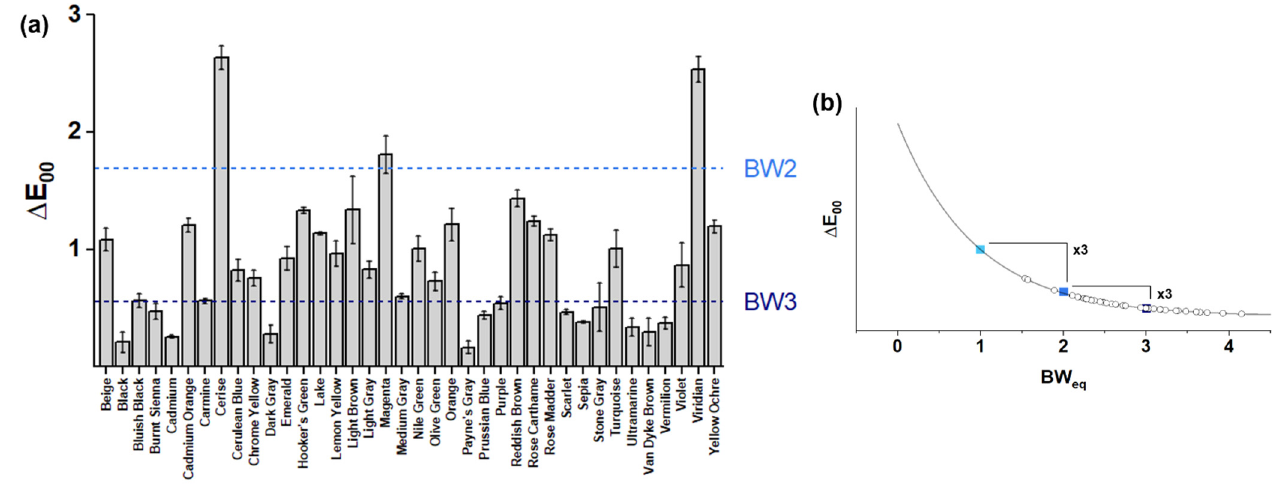
Figure 6. Δ E 00 values obtained for 38 Dr. Ph. Martin’s Synchromatic Transparent Water Colors after 600 secs of illumination with MFT ( a ), which were then fitted to an exponential decay function ( b ) to obtain relative BW eq scores for each color, each BW dye appeared to have three times the sensitivity as the next one. Table 3. Δ E00 values obtained for 38 Dr. Ph. Martin’s Synchromatic Transparent Water Colors after 600 secs of illumination with MFT and the resulting BWeq scores from exponential fitting.